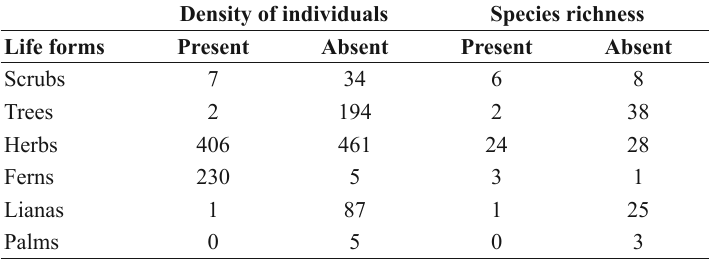
Density of individuals and species richness of plant life forms in areas with or without Brachiaria decumbens Stapf